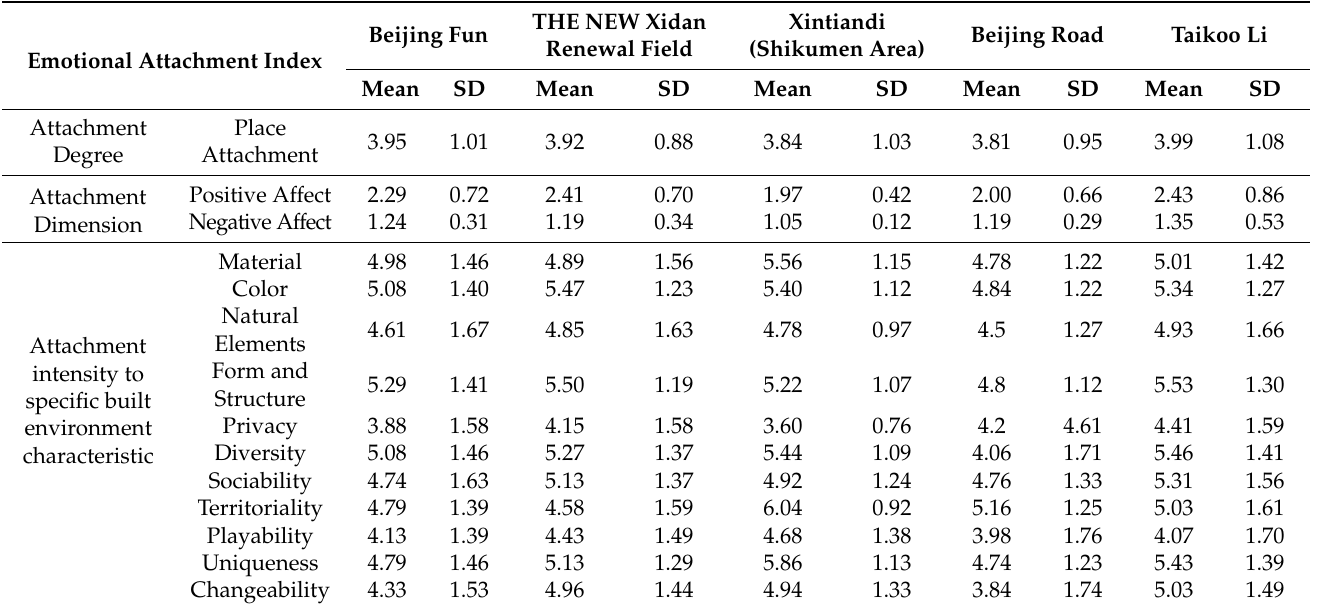
Table 2. Results of emotional attachment indicators of the five